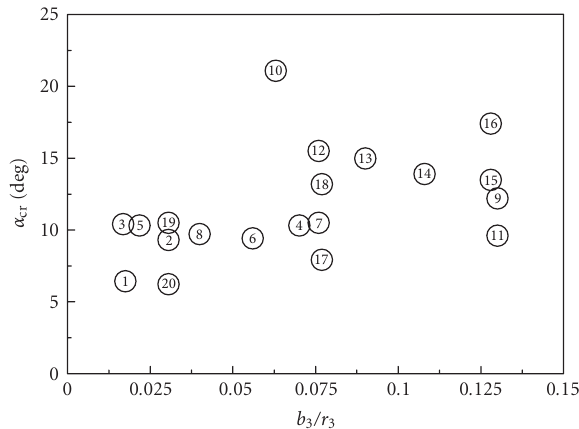
Figure 2: Critical inlet flow angle for rotating stall in the literature [16,